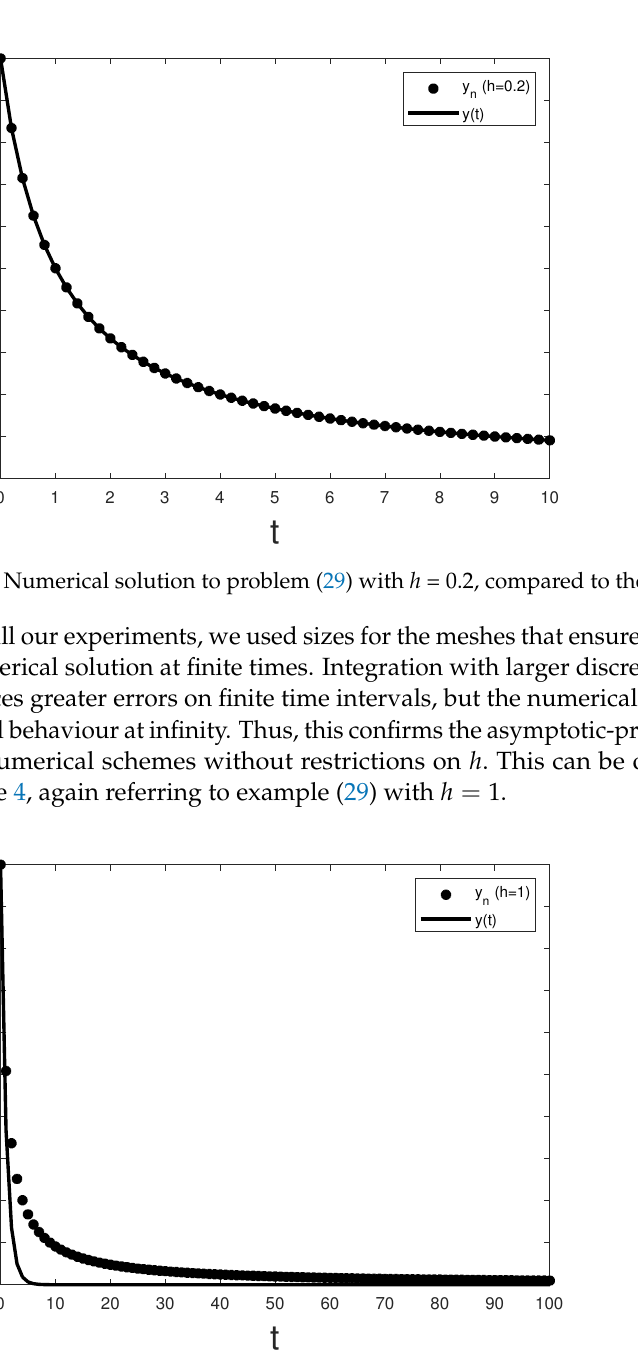
Figure 4. Numerical solution to problem (29) with h = 1, compared to the analytical